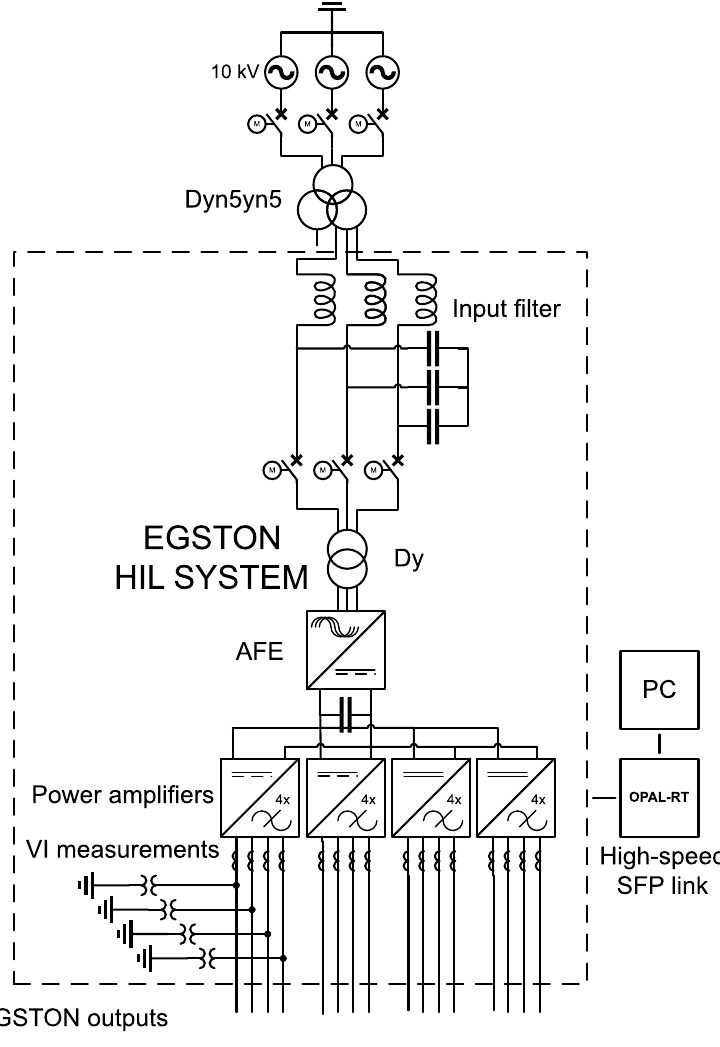
Figure 4. Schematic of power hardware-in-the-loop (PHIL) setup at Flexible Power Grid